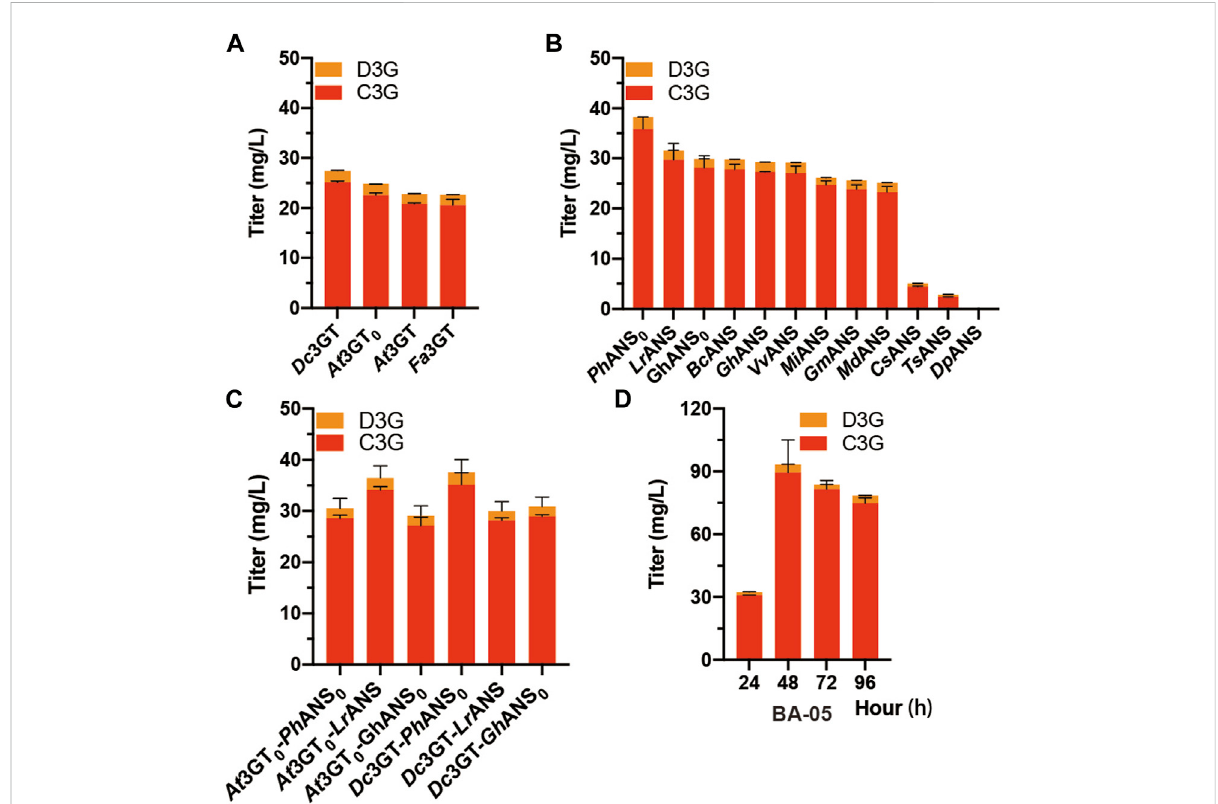
FIGURE 3 Screening of ANS and 3 GT (A) At 3GT, At 3GT 0 , Fa 3GT, and Dc 3GT represent BA-01, BA-02, BA-03, and BA-04, respectively, harboring the pY26-P TDH1 - Fa DFR-T GAA1 -P GAL10 - Md ANS-T ALT1 -P INO1 - Md GSTF6- T CYC1 plasmid for 24-h cultivation supplemented with 500 mg/L dihydro fl avonols (B) BA-04 harboring 12 different pY26-P TDH1 - Fa DFR-T GAA1 -P GAL10 -ANSs-T ALT1 -P INO1 - Md GSTF6-T CYC1 plasmids (ANSs indicate 12 different types of ANS) for 24-h cultivation supplemented with 500 mg/L dihydro fl avonols (C) Two strains BA-02 and BA-04 and three plasmids pY26-P TDH1 - Fa DFR-T GAA1 -P GAL10 -ANSs-T ALT1 -P INO1 - Md GSTF6-T CYC1 plasmid (ANSs indicate Ph ANS 0 , Lr ANS, and Gh ANS 0 ) composed of six combinations for 24-h cultivation supplemented with 500 mg/L dihydro fl avonols (D) 96-h fermentation of the BA-05 strain; 500